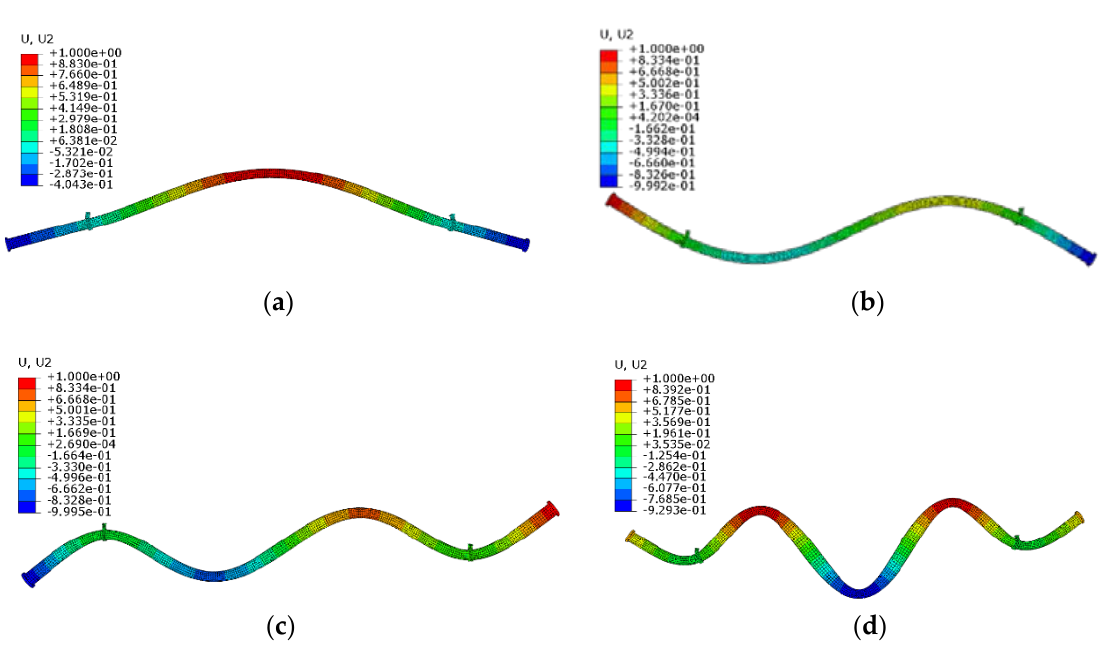
Figure 11. Modal shape of the rigid pipeline: ( a ) first-order modal shape; ( b ) second-order modal shape; ( c ) third-order modal shape; ( d ) fourth-order modal shape. Table 1. Comparison of natural frequency between experiments and finite element model analysis (FEMA).